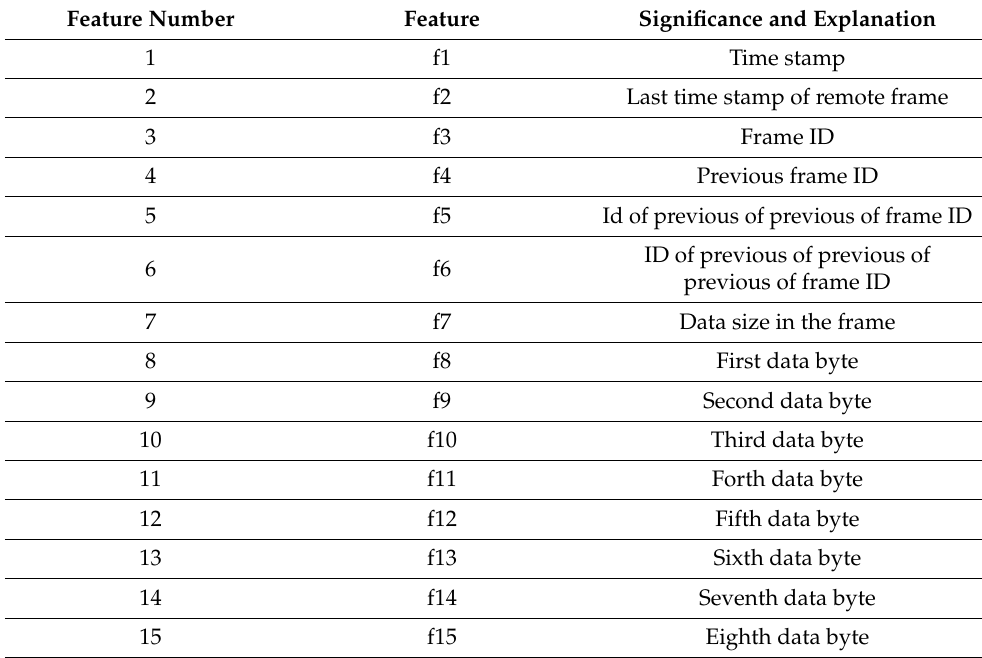
Table 2. Key Features extracted from CAN vehicle datasets used in ML classifications. Feature Number